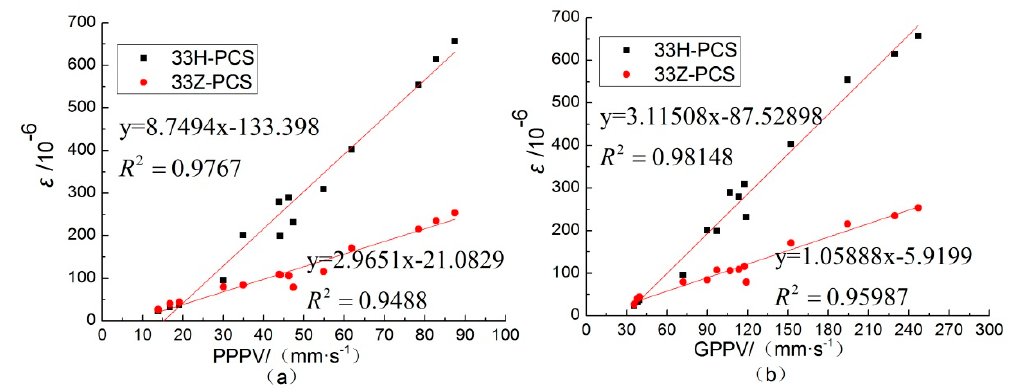
Figure 18. The correlation between peak strain and PPVV or GPPV ( R = 3.75 m and R = 2.7 m): ( a ) the peak strain and PPVV; ( b ) the peak strain and GPVV.